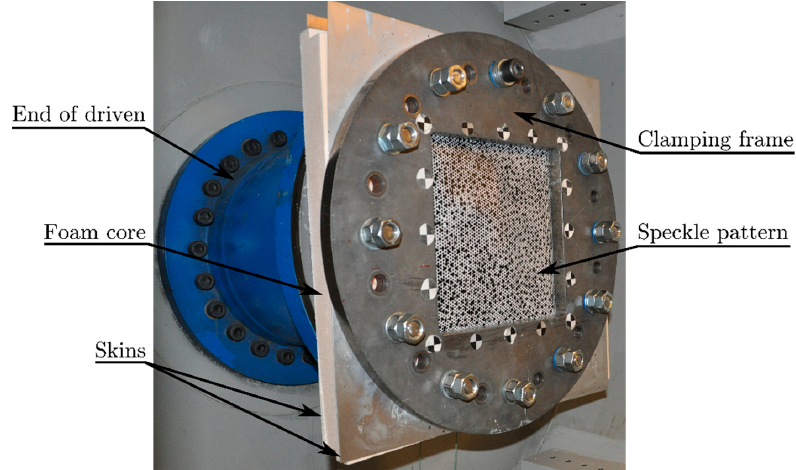
Figure 6. Image showing the mounting of the sandwich component at the end of the shock tube driven section.